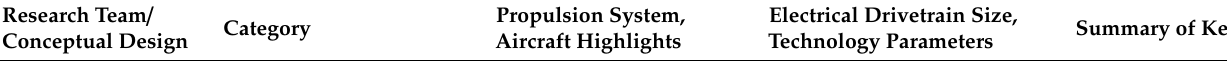
Table 2. Summary of Key Findings of Electric Aircraft